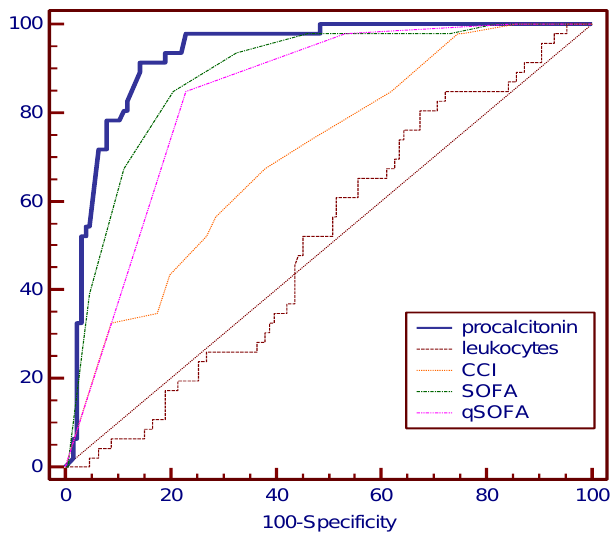
Figure 2. Pairwise comparison of ROC curves for the SIRS group.